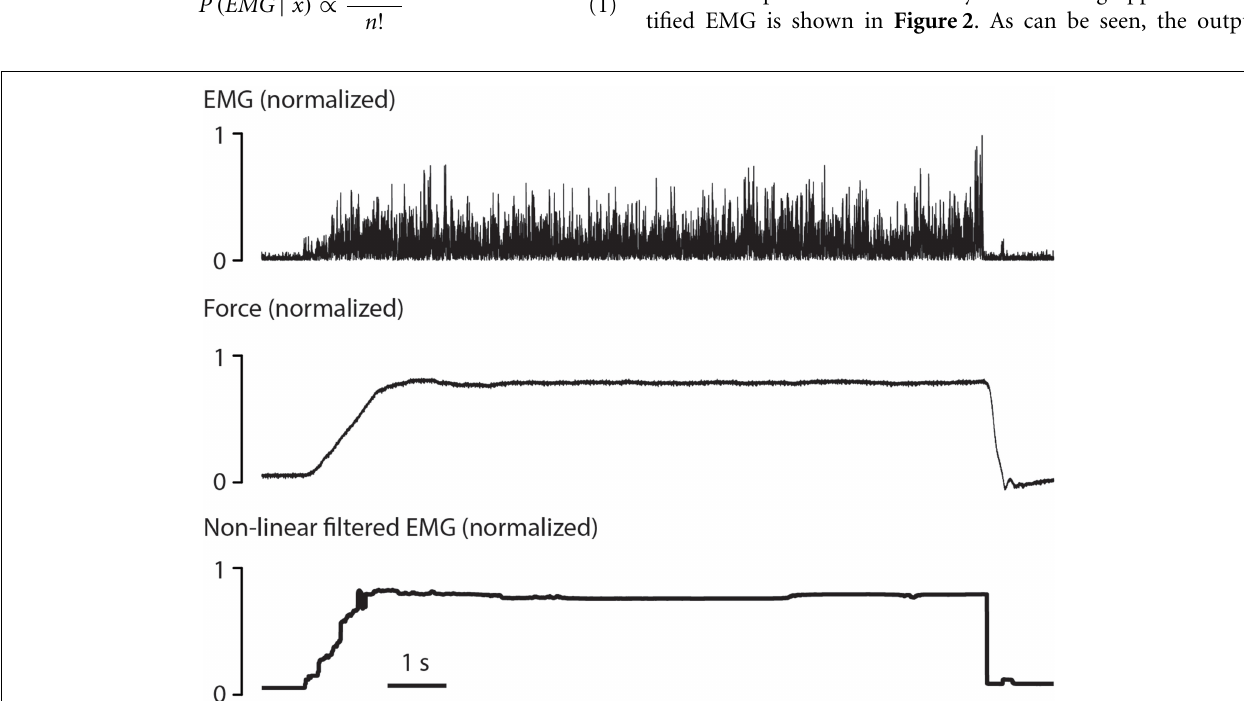
FIGURE 2 | Example of non-linear Bayesian filtering, re-analyzed and produced from previous dataset (Sanger, 2007). A rectified surface EMG signal (top) was recorded during 10s of isotonic contraction in the biceps. The